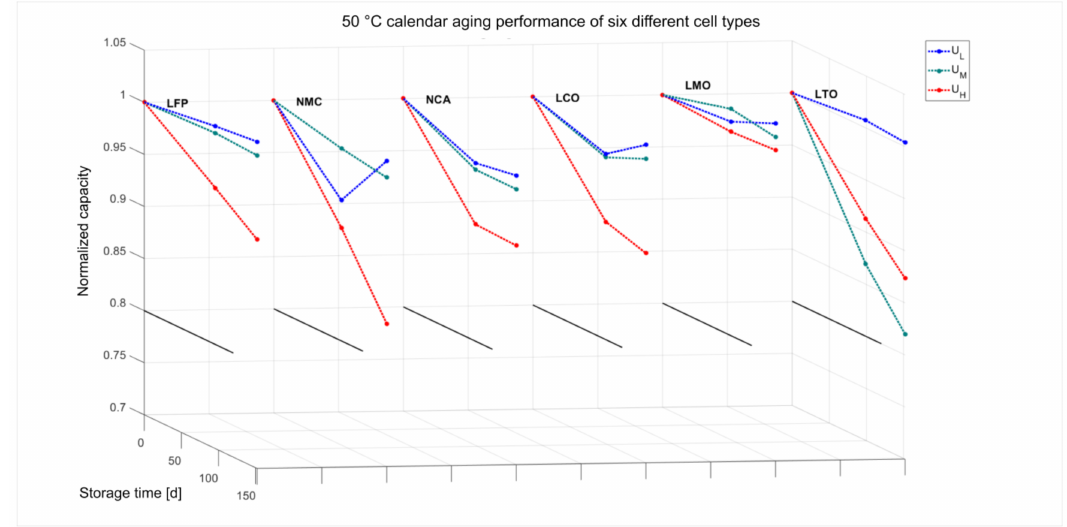
Figure 4. Normalized discharge-capacity decrease of six chemistries at 50 ◦ C storage over 150 days at three storage voltages (U L -voltage low, U M -voltage mid, U H -voltage high), each plotted point displays the average capacity of all individual cells at that same